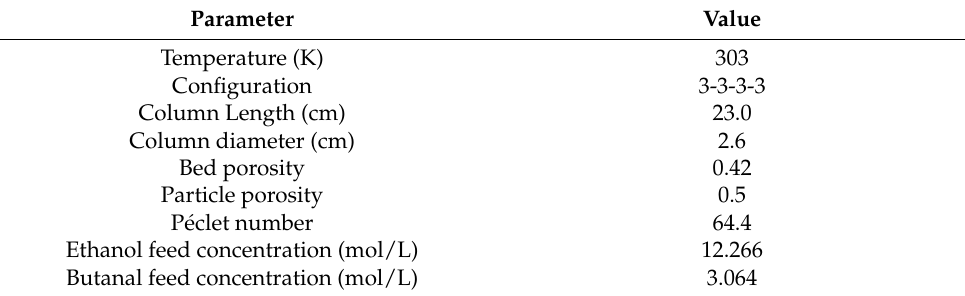
Table 4. Simulated moving bed reactor (SMBR) conditions.